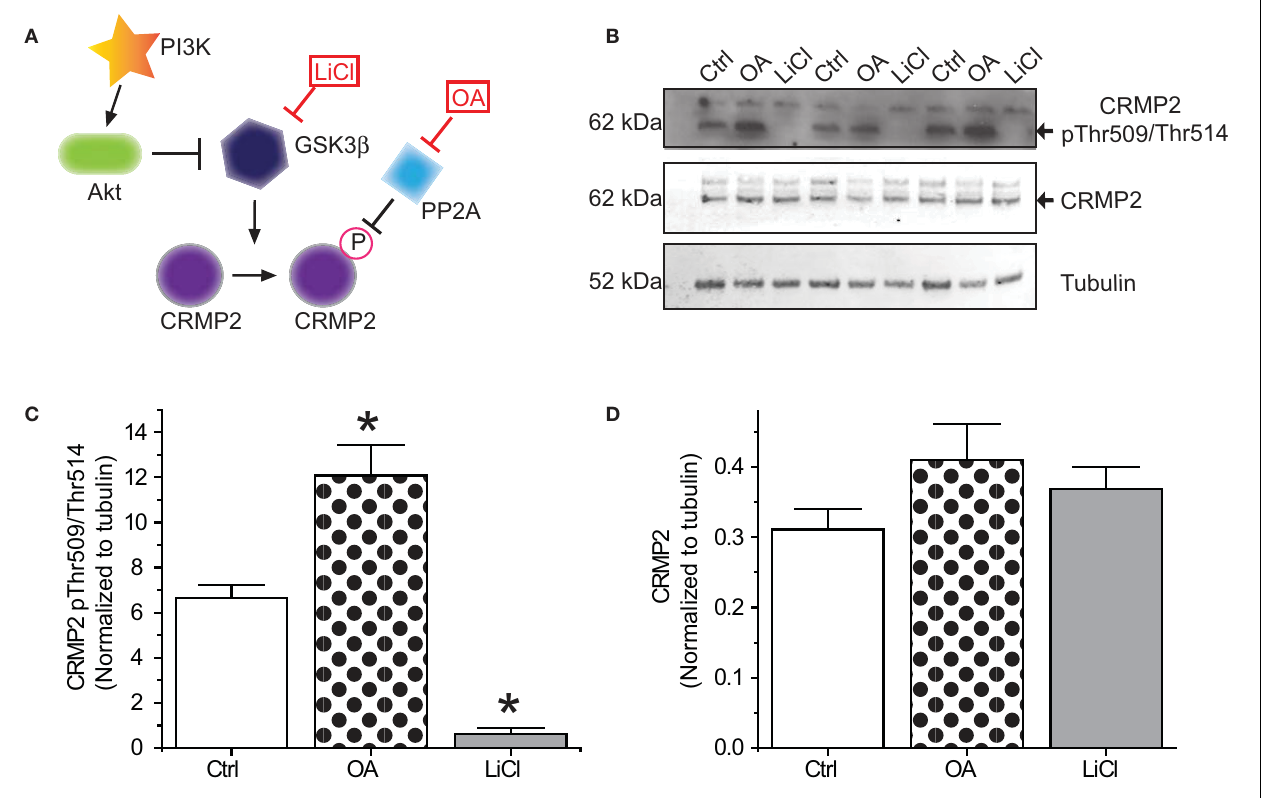
FIGURE 1 | Phosphorylation of CRMP2 by GSK β . (A) Signaling cascade involved in changes in phosphorylation of CRMP2 by GSK3 β . Inactivation of GSK3 β occurs following activation of Akt or exogenous exposures to lithium chloride (LiCl). Dephosphorylation of CRMP2 by PP2A is prevented by exposure to okadaic acid (OA). (B) Levels of GSK3 β -phosphorylated CRMP2